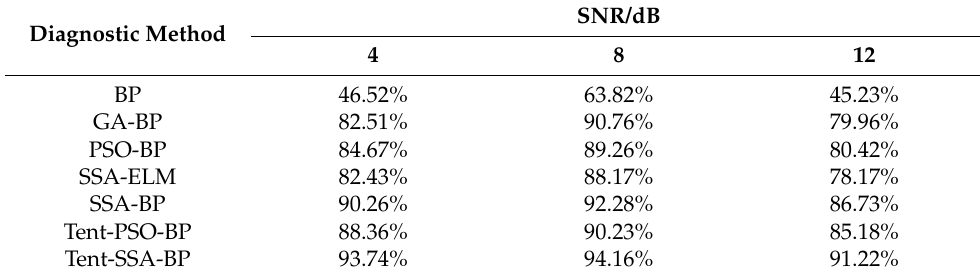
Table 5. Prediction accuracy of different methods under different noise conditions.